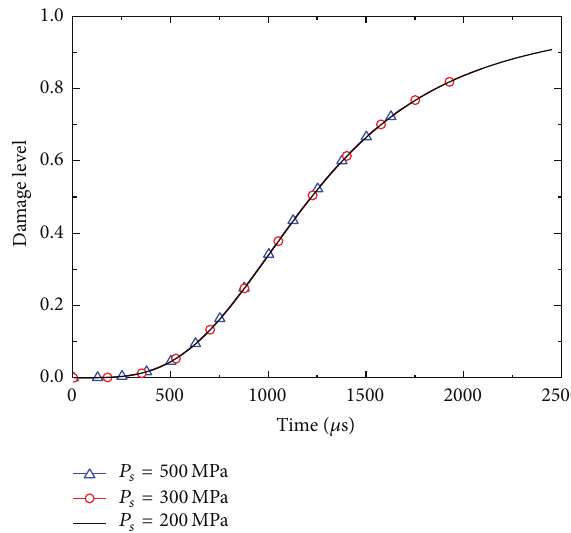
Figure 5: Time evolution of pore radius under lower pressures with the improved model.